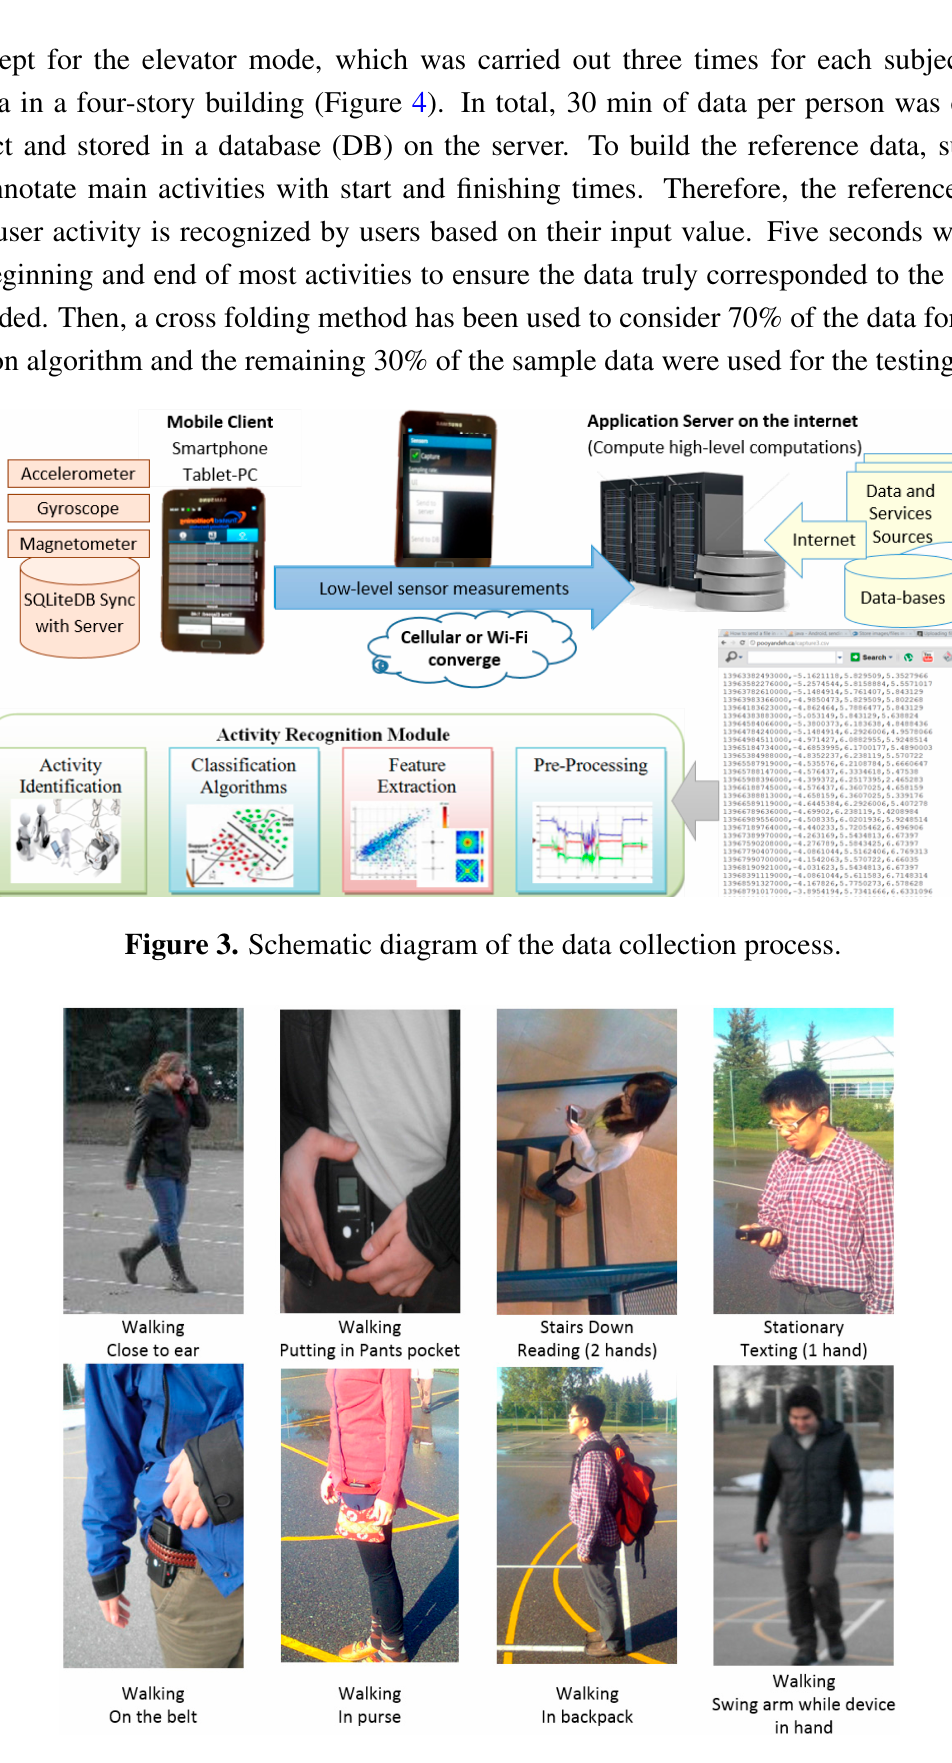
Figure 4. Collecting training datasets for different activities and device placements.